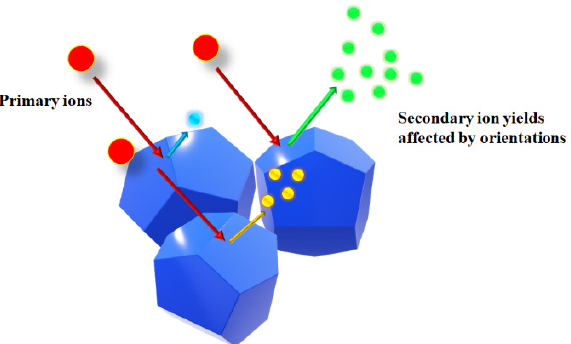
Figure 9. The possible influence of crystal orientation on the amounts of secondary